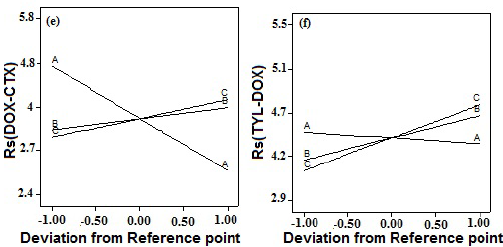
Figure 2. Perturbation plots for screening of factors affecting HPLC-UV method describing the effect of the studied factors on the responses ( a ) retention time of (TMP), ( b ) retention time of (CST), ( c ) resolution of (TMP-CIP) peaks, ( d ) resolution of (CIP-CTX) peaks, ( e ) resolution of (CTX-DOX) peaks, and ( f ) resolution of (DOX-TYL) peaks, where A, is acetonitrile percentage (ACN%), B, is column temperature and C, is flow rate.